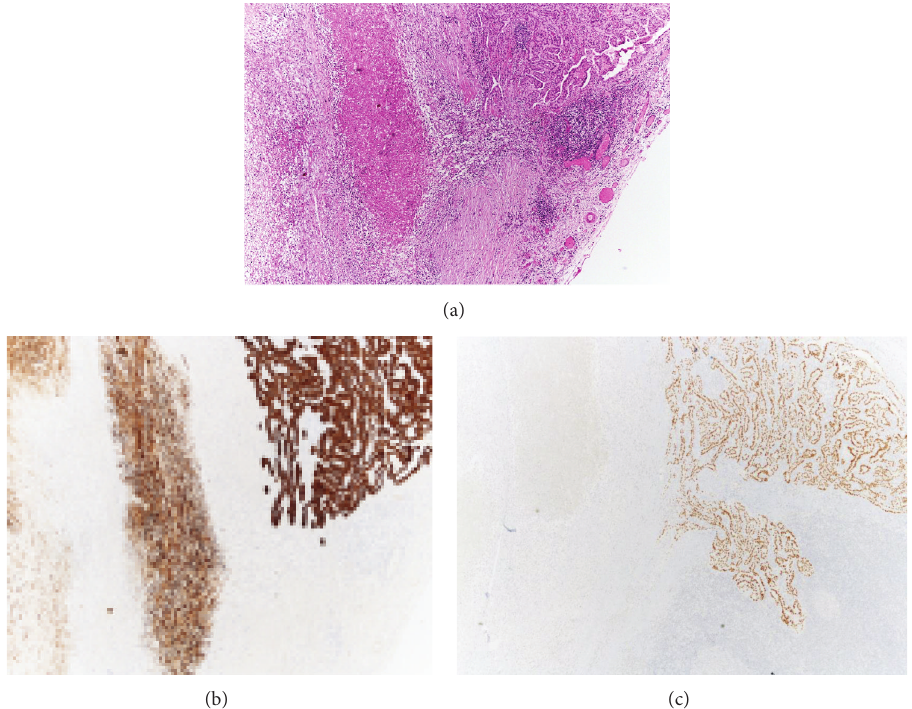
Figure 9: Lymph node metastasis of WDTC with anaplastic areas. Residual foci of papillary carcinoma are present in the right upper corner but the metastatic deposits are constituted mainly by spindle cells with wide necrotic areas (a). While both WDTC and ATC are immunoreactive with pankeratin (b), TTF1 is positive only in the WDTC